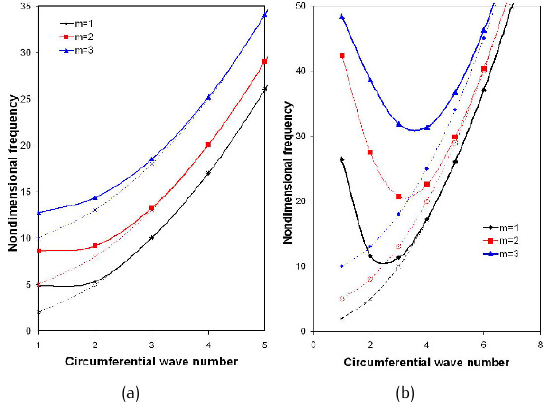
Figure 9. Natural frequencies of simply supported cylindrical panels: (a) β = π/ 12 ; (b) β = π/ 2